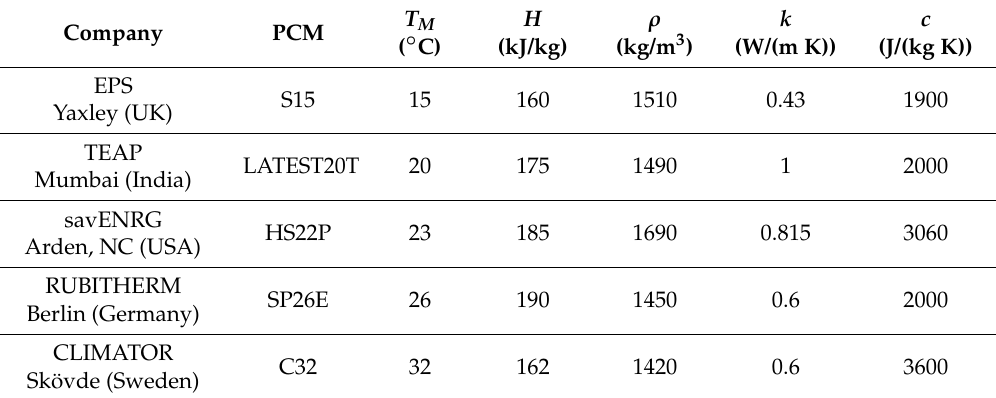
Table 1. Thermophysical properties of the different types of PCM.